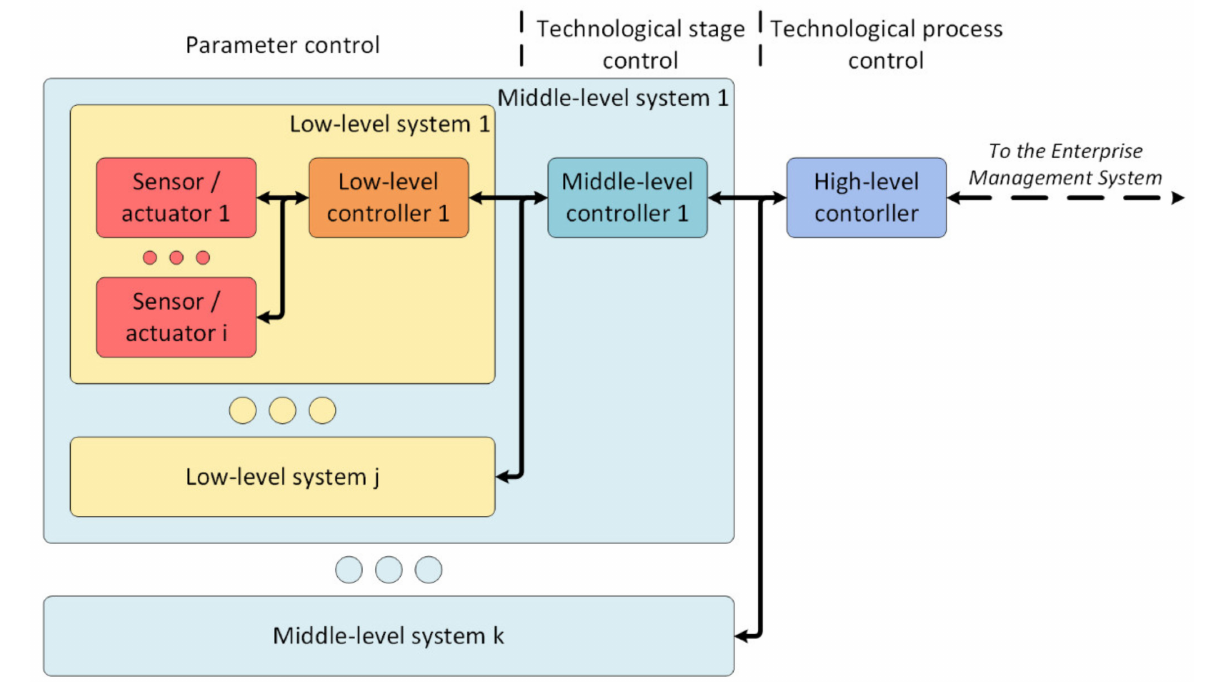
Figure 8. The architecture of the digital production